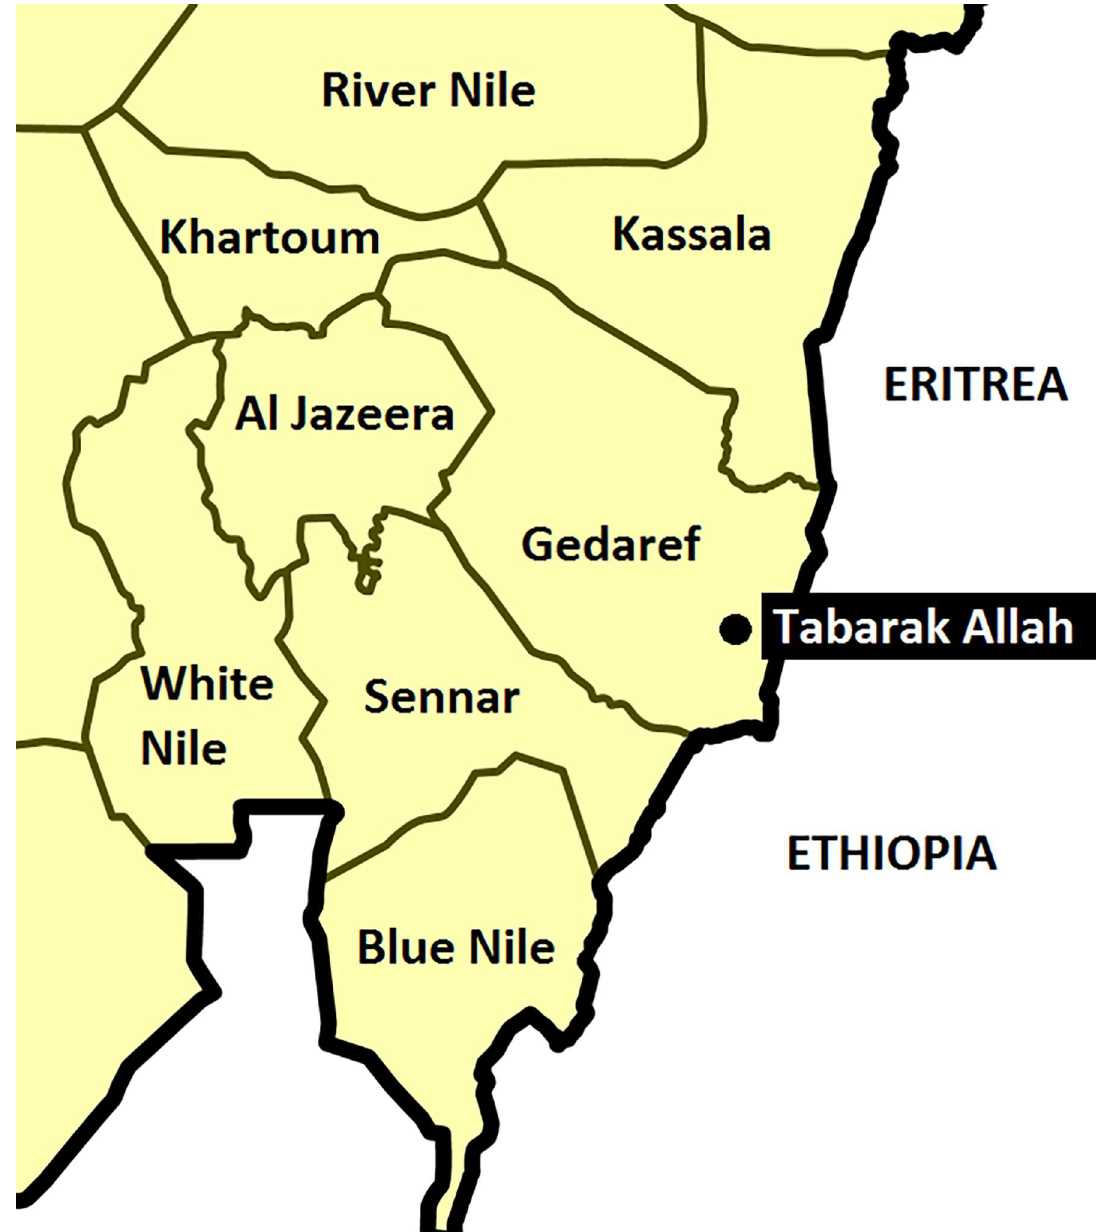
Fig 1. Study location. Tabarak Allah, Gedaref province,